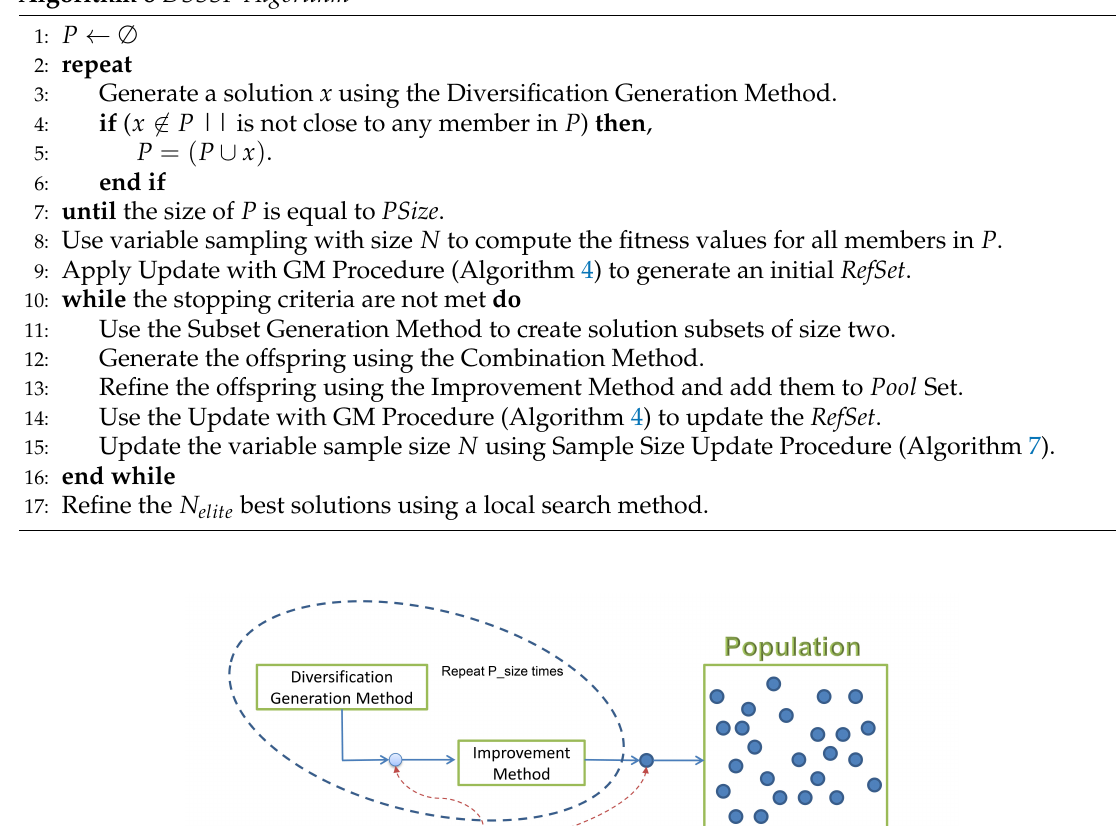
Algorithm 8 DSSSP Algorithm